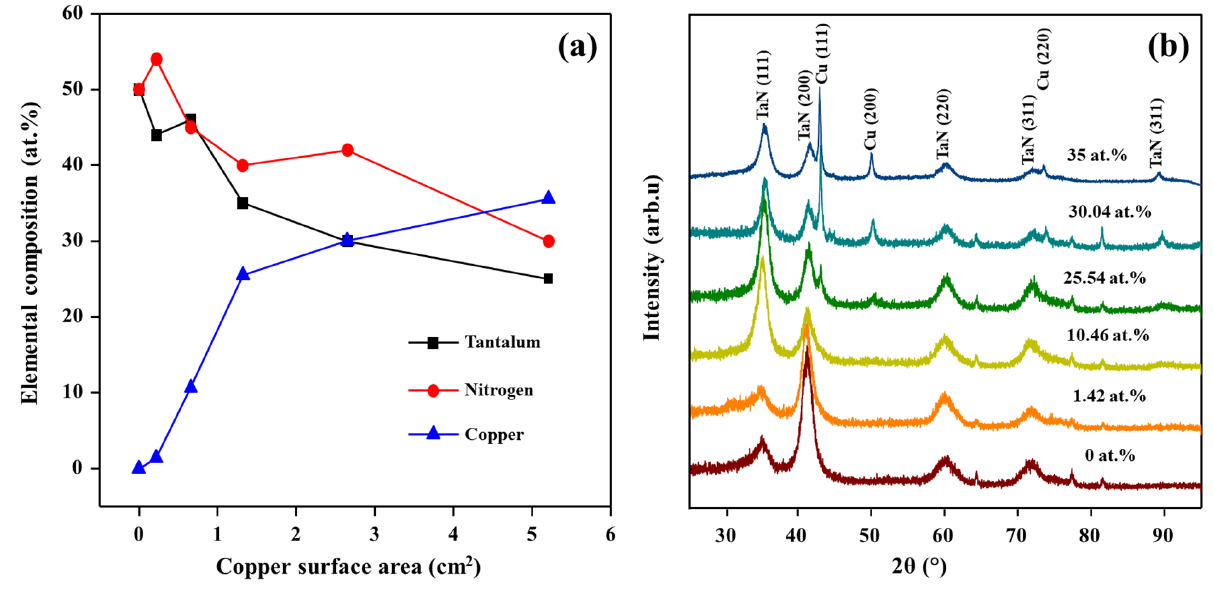
Figure 1. ( a ) Elemental composition of TaN/Cu coatings with respect to increases in the surface area of the Cu target; ( b ) XRD patterns of TaN/Cu coatings with different Cu content (at.% = Cu content in atomic %).